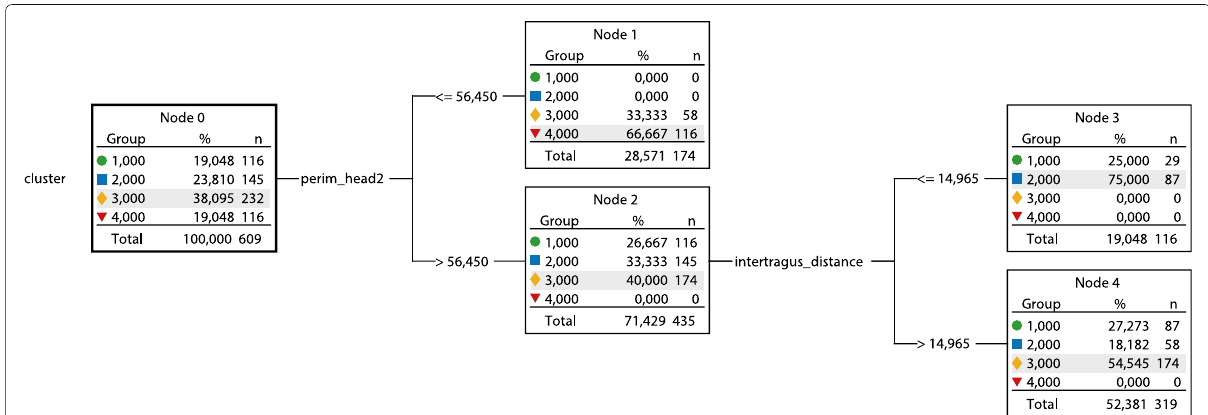
Fig. 7 Decision tree that classifies the subjective perception of the subjects with the objective measurements intertragus_distance and perim_head2